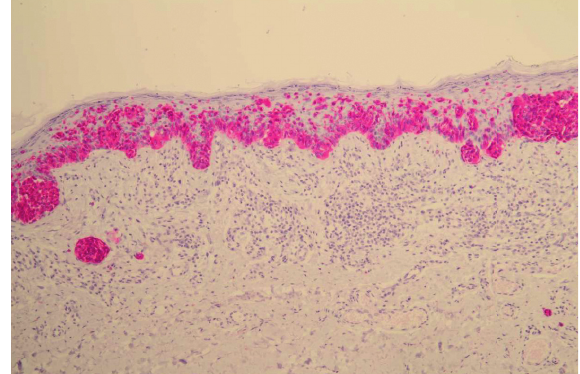
Figure 6: Immunohistochemistry shows bridging and pagetoid spread of atypical melanocytes (Melan A red ×